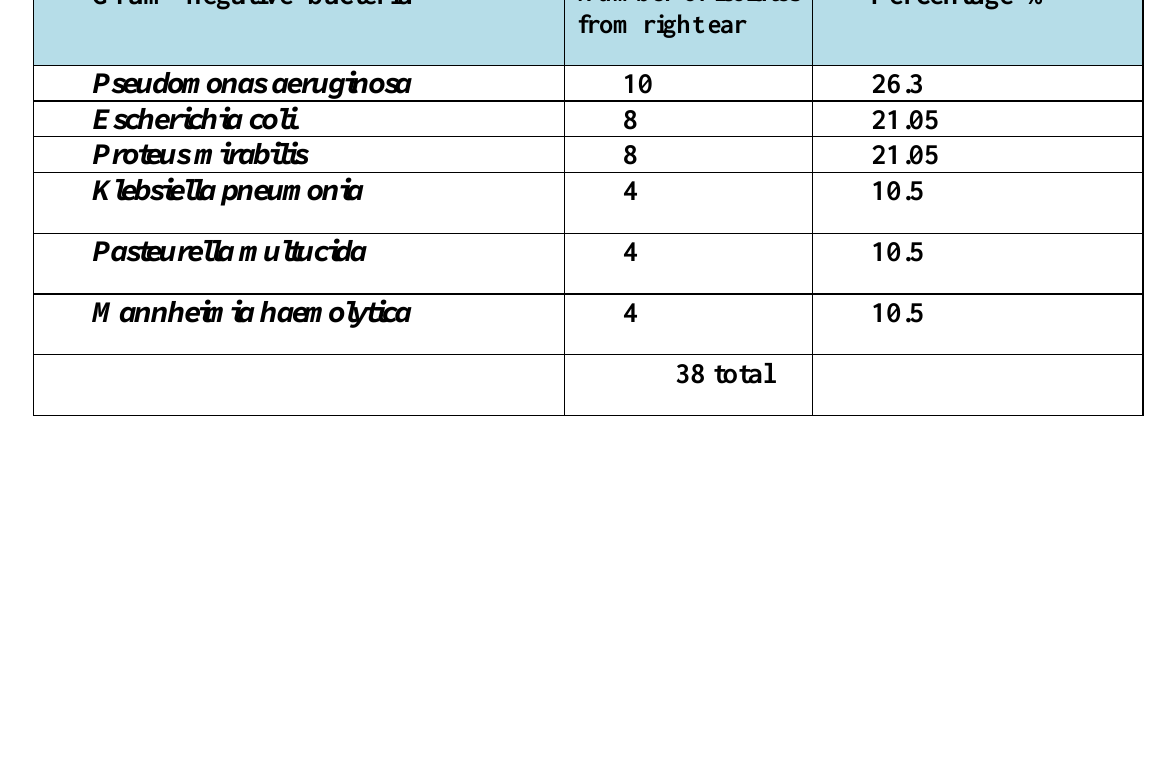
Table 5: Numbers of gram negative bacteria from infected right ear in sheep Gram- negative bacteria Number of isolates Percentage from right ear